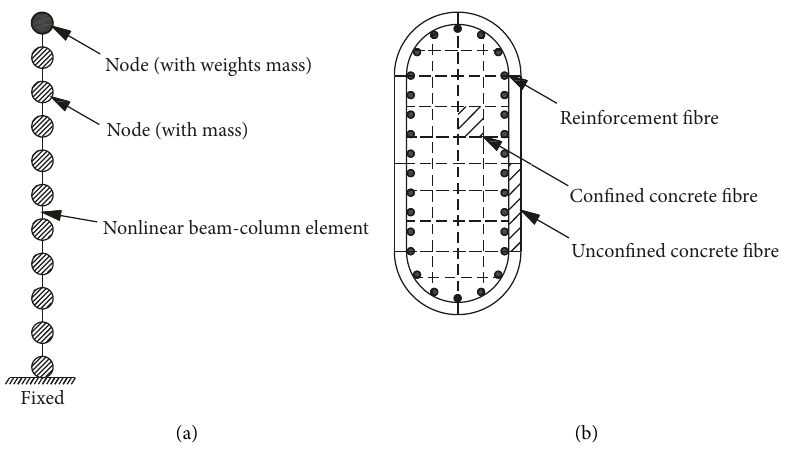
Figure 9: (a) Element model. (b) Fibre section of the experimental pier specimen.